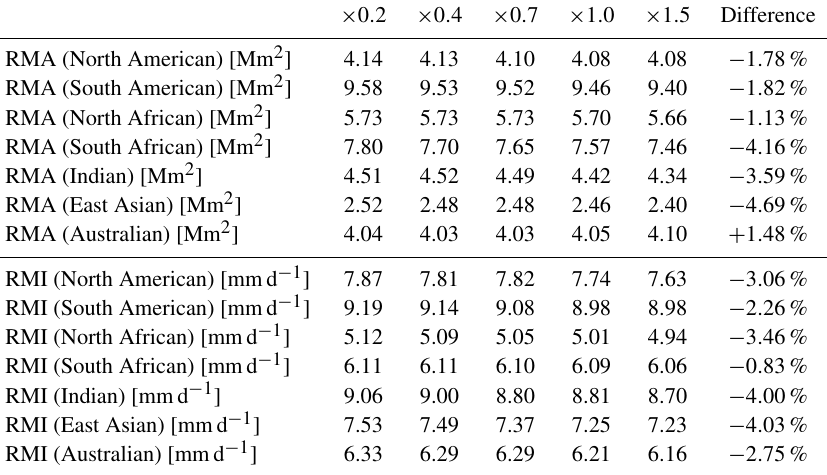
Table 2. Values of regional monsoon area (RMA) and regional monsoon intensity (RMI), averaged over the years 1950–2014 and all five ensemble members. The difference column is the change from × 0 . 2 (lowest scaling) to × 1 . 5 (highest scaling), expressed as a percentage. × 0 . 2 × 0 . 4 × 0 . 7 × 1 . 0 × 1 .